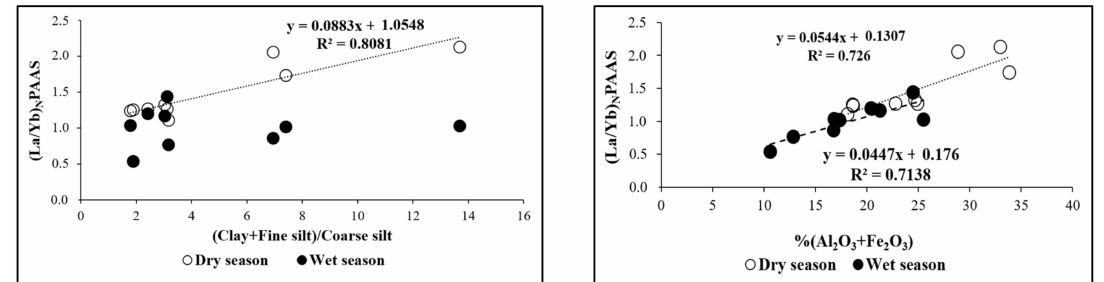
Figure 5. Relationships between the average (La / Yb) N ratios and the abundance of the finest particles on one hand ( left ) and the average percentage of (Al 2 O 3 + Fe 2 O 3 ) on the other hand ( right ) for the Lom é lagoon fine sediments ( < 63 µ m) during the dry and wet seasons. Table 3. Average Ce and Eu anomalies (Ce* and Eu*, respectively) and La / Yb normalized ratios (La / Yb) N in the Lom é lagoon fine sediments ( < 63 µ m) for dry and wet seasons. Eu* and (La / Yb) N average values are statiscally di ff erent between the two seasons ( p -values < 1%). PAAS Normalization Season Min Max Mean Dry season 1.08 1.25 1.16 Eu* Wet season